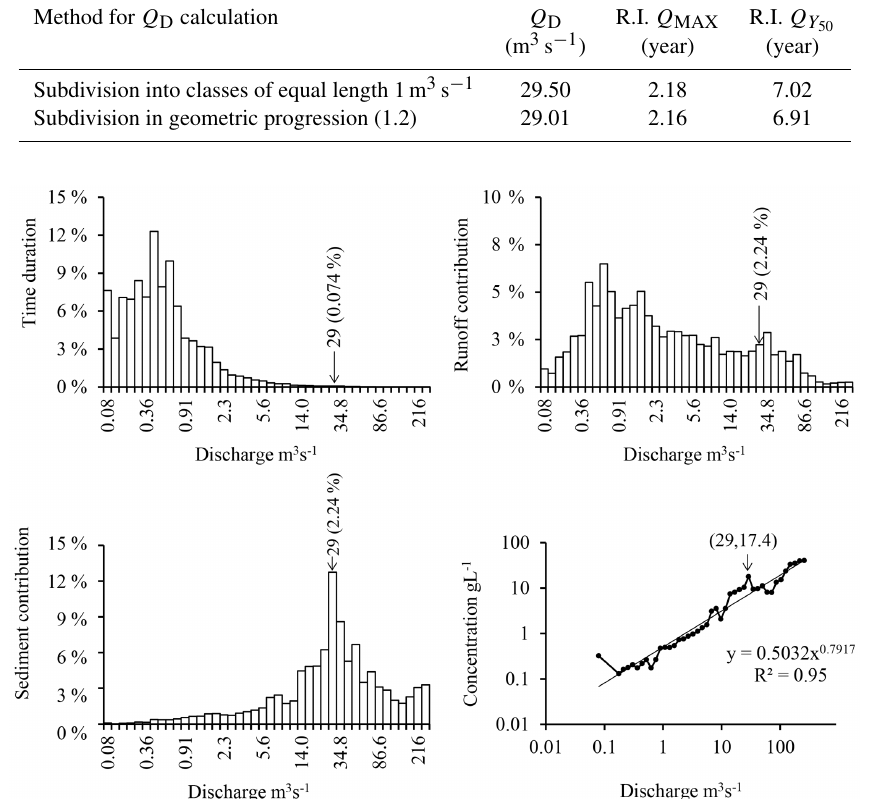
Table 2. Recurrence intervals, R.I. Q MAX and R.I. Q Y amplitude 1m 3 s − 1 and of geometric progression.